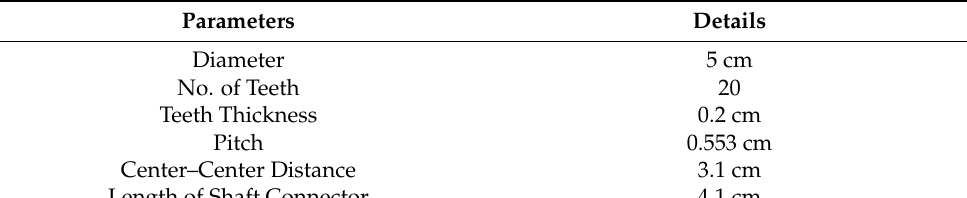
Table 2. Specification of driving gears.